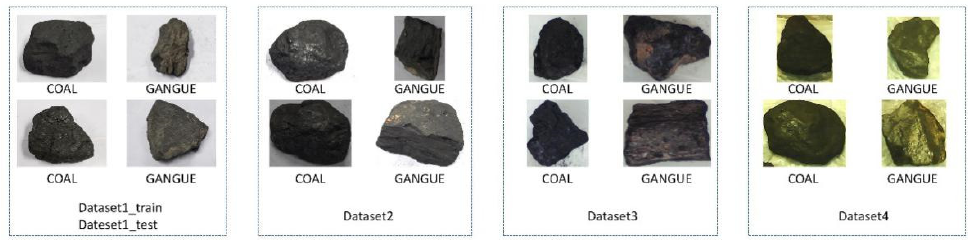
Figure 2. Sample full-scale images in different datasets.